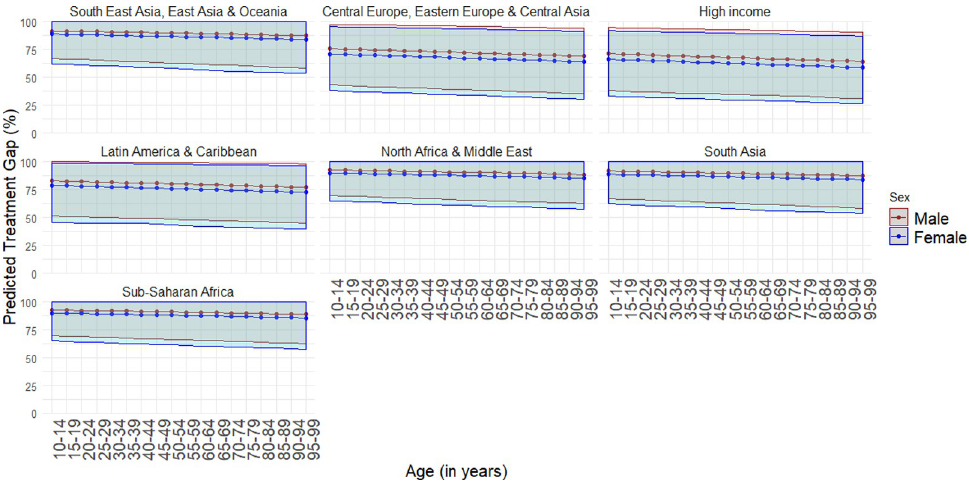
Fig 3. Predicted treatment gap (lines) and 95% UIs (shaded) for any mental health service use by age, sex, and GBD superregion. Note: 95% UIs incorporate between-study heterogeneity. GBD, Global Burden of Disease; UI, uncertainty